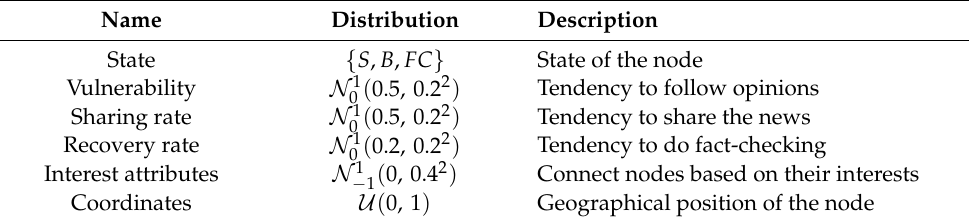
Table 2. Attributes of common and influencer